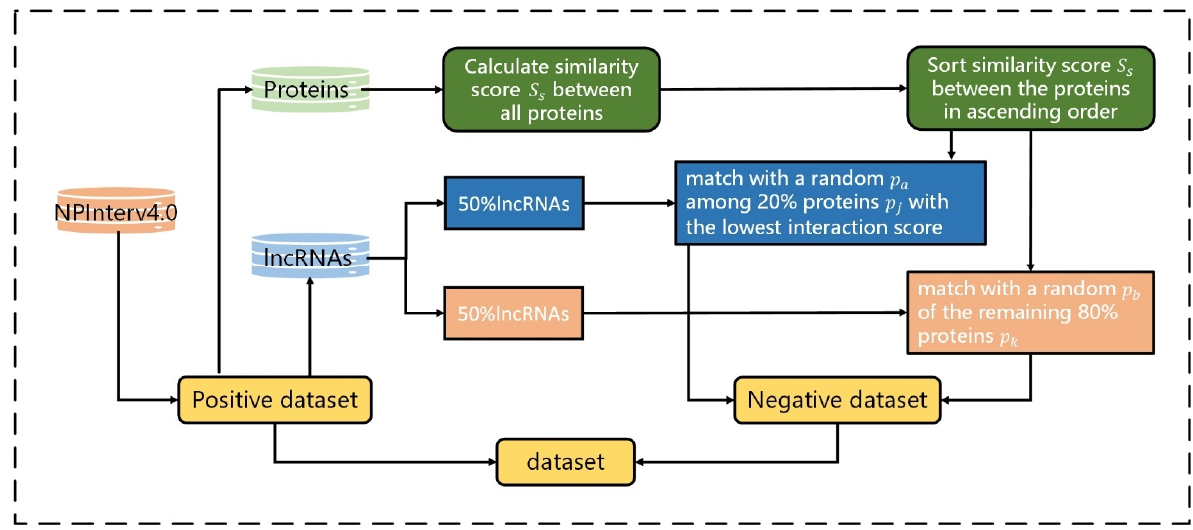
Figure 2. The flowchart of constructing reliable negative samples. The positive dataset is constructed